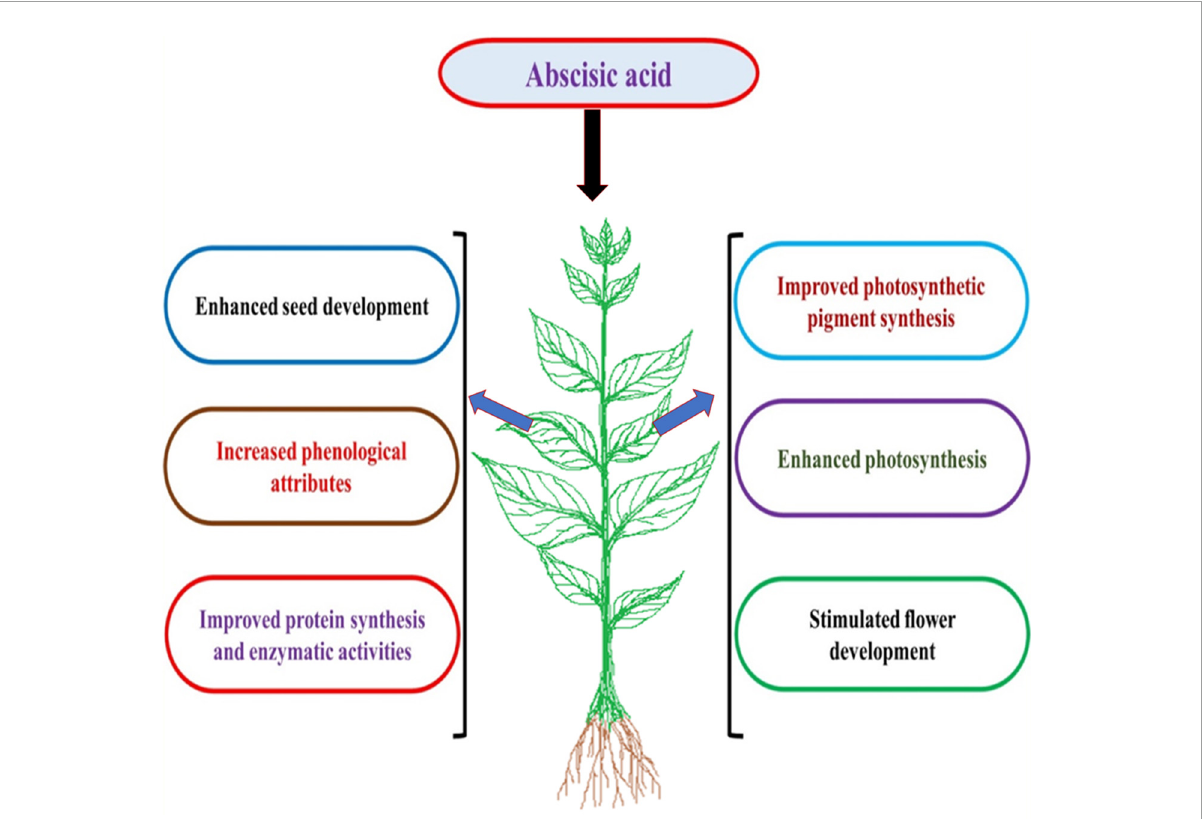
FIGURE3 The effect of exogenous application of abscisic acid (ABA) on plant growth and physiological